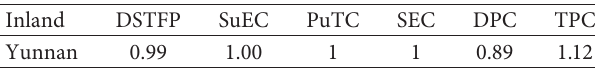
Figure 3: Gradient lift regression tree clustering. Table 2: Five indicators of Yunnan province.